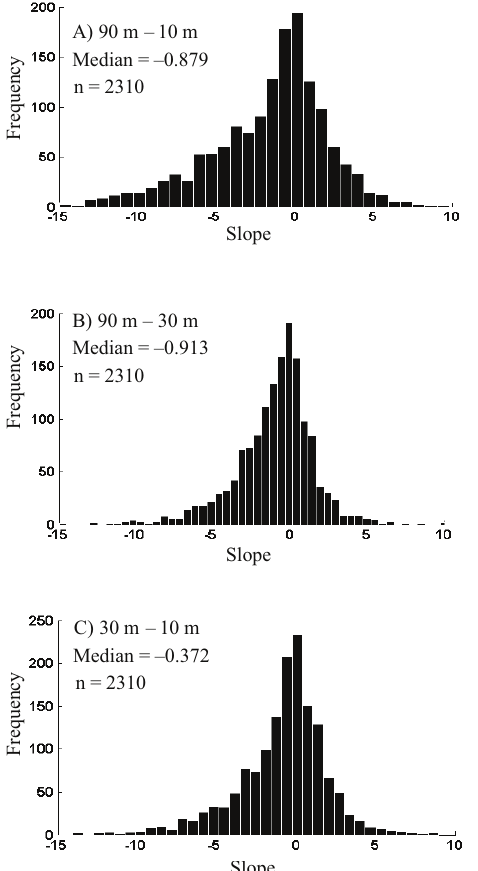
Fig. 5. The frequencies of the differences in the estimated slope using cell sizes of 10 m, 30 m and 90 m: A) 90 m – 10 m,